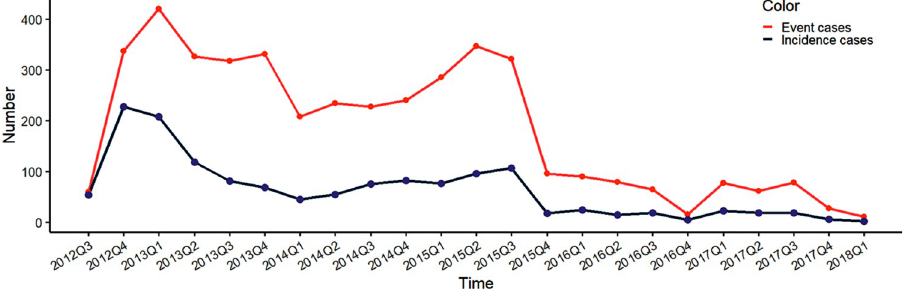
Fig 3. Diarrhea incidence (person per thousand population) and event (cases per thousand population) rates over the course of the study (Q3 2012 to Q1